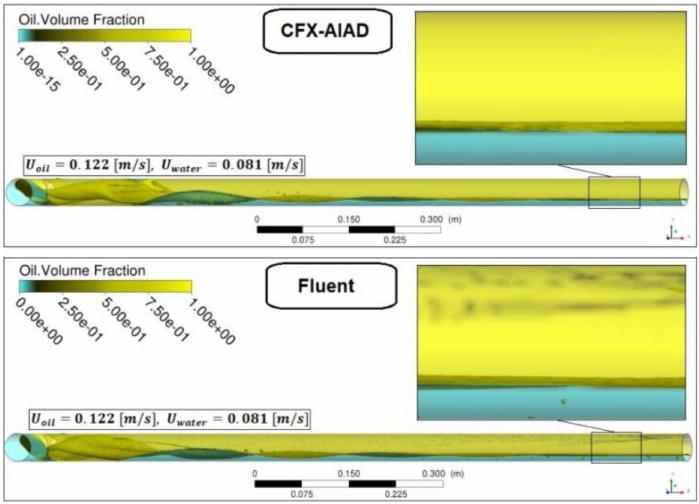
Figure 15. Oil volume fraction in the entire domain at U oil = 0.122 m / s, U water = 0.081 m / s. In the third case, the experiment presents oil and water velocities as U oil = 0.325 m / s and U water = 0.325 m / s. Here, the flow is stratified and mixed (ST & MI) with oil droplets